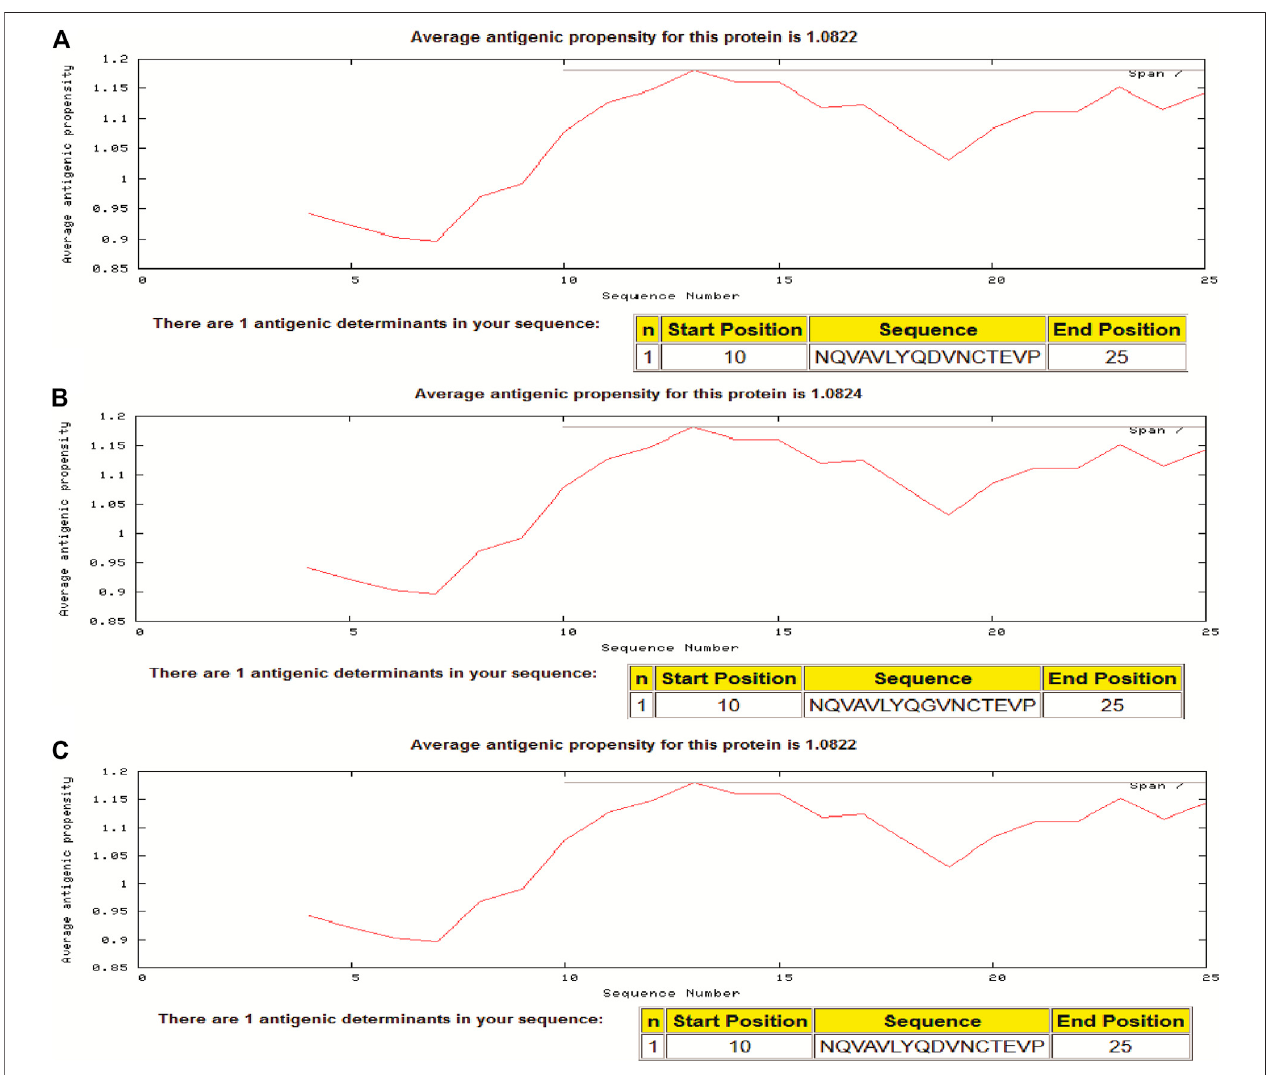
FIGURE 4 | Antigenic propensity of two different SARS-2COV-2 sequences and Pangolin-CoV. (A) Pangolin-CoV, (B) SARS-CoV-2 (D614G) Variant, (C) Reference sequence at 614 position in spike glycoprotein sequence.